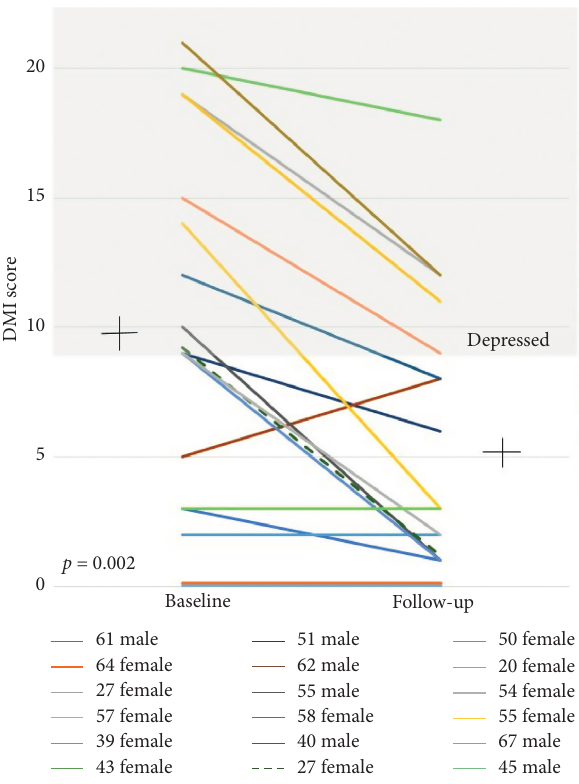
Figure 5: Changes in DMI-10 score pre-post LTX.